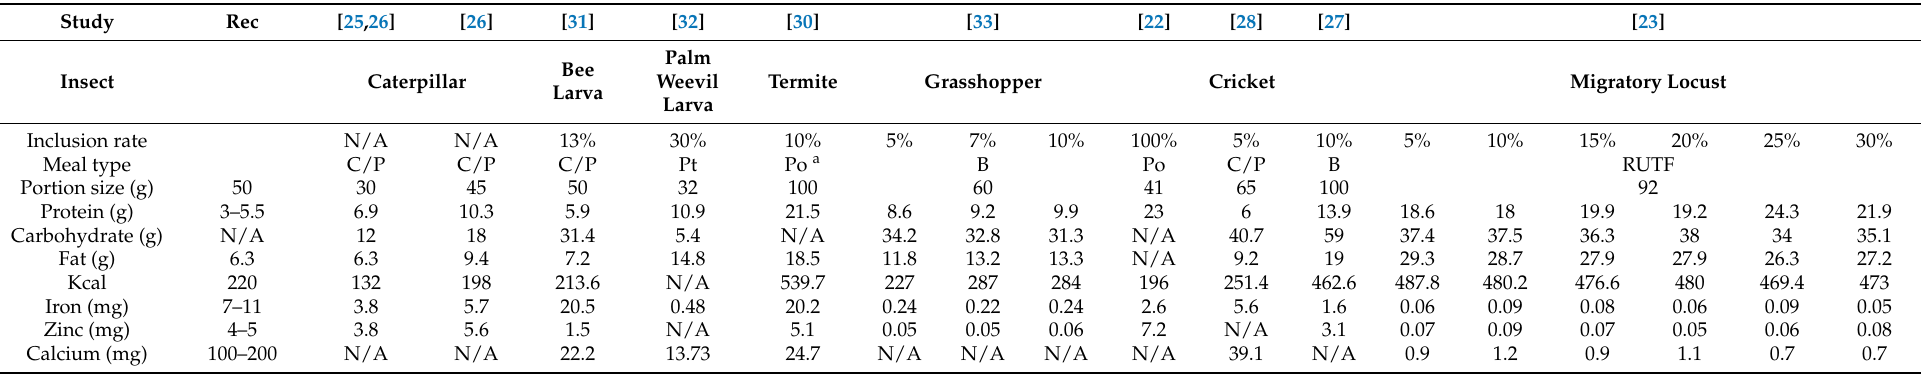
Table 3. The nutritional profile of one serving of insect-based meal and the referenced amounts of macronutrients in complementary foods for 6–23-month-old